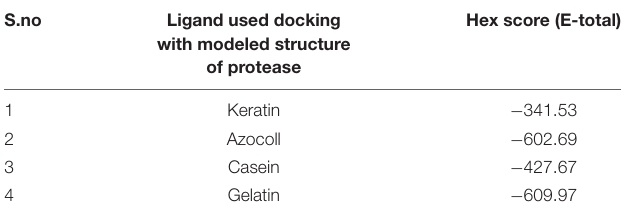
TABLE 5 | Docking scores of modeled structure of protease docked with different substrate. S.no Ligand used docking with modeled structure